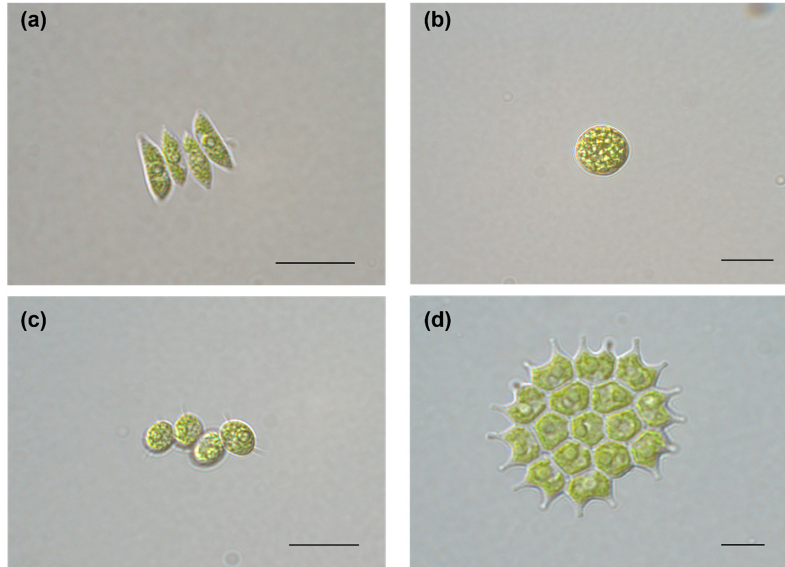
Figure 1. Light microscopy of each microalgal strain. ( a ) Tetradesmus obliquus KNUA019; ( b ) Asterarcys quadricellulare KNUA020; ( c ) Desmodesmus sp. KNUA024; ( d ) Pseudopediastrum sp. KNUA039. Scale bar: 10 μ m.